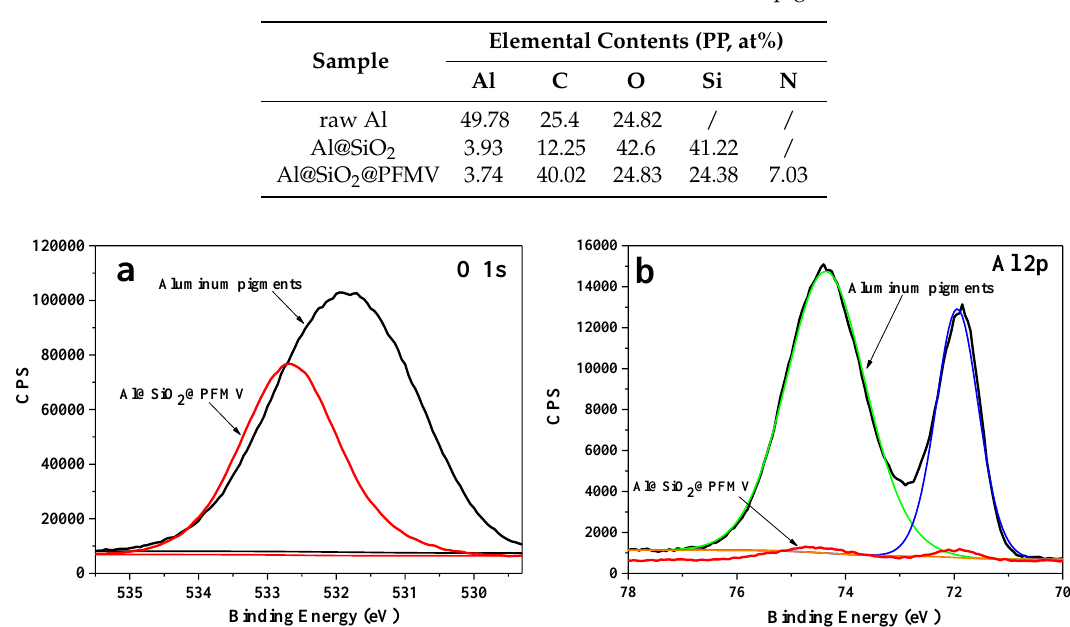
Table 1. Elemental contents on the surface of aluminum pigments.